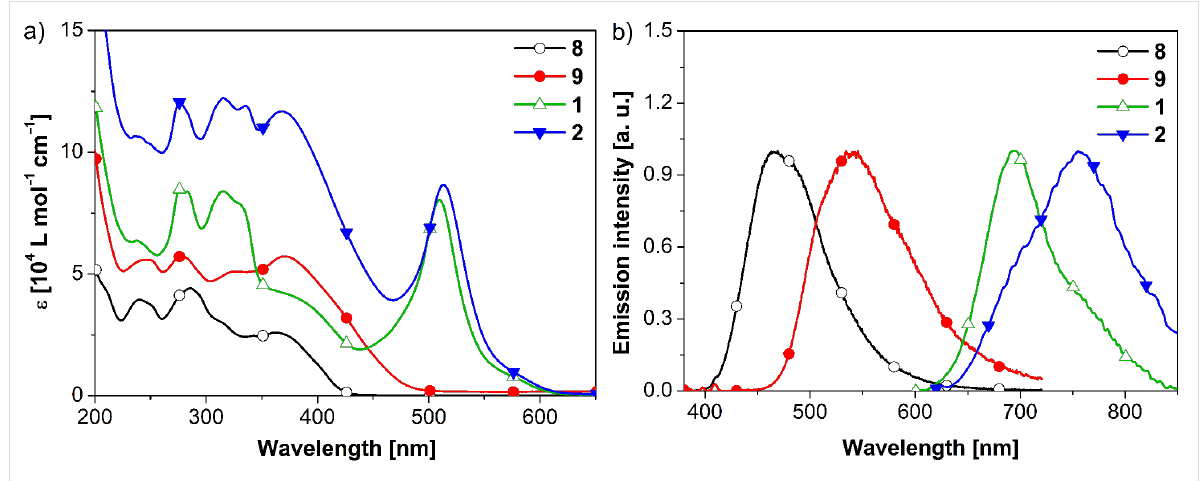
Figure 1: (a) Absorption spectra of ligands and their corresponding Ru(II)-dendrimers in acetonitrile solution at 293 K. (b) Normalized emission spectra of ligands (excited at λ exc = 365 nm), and the corresponding Ru(II)-complexes (excited at λ exc = 510 nm), in dilute deaerated acetonitrile solu- tion at 293